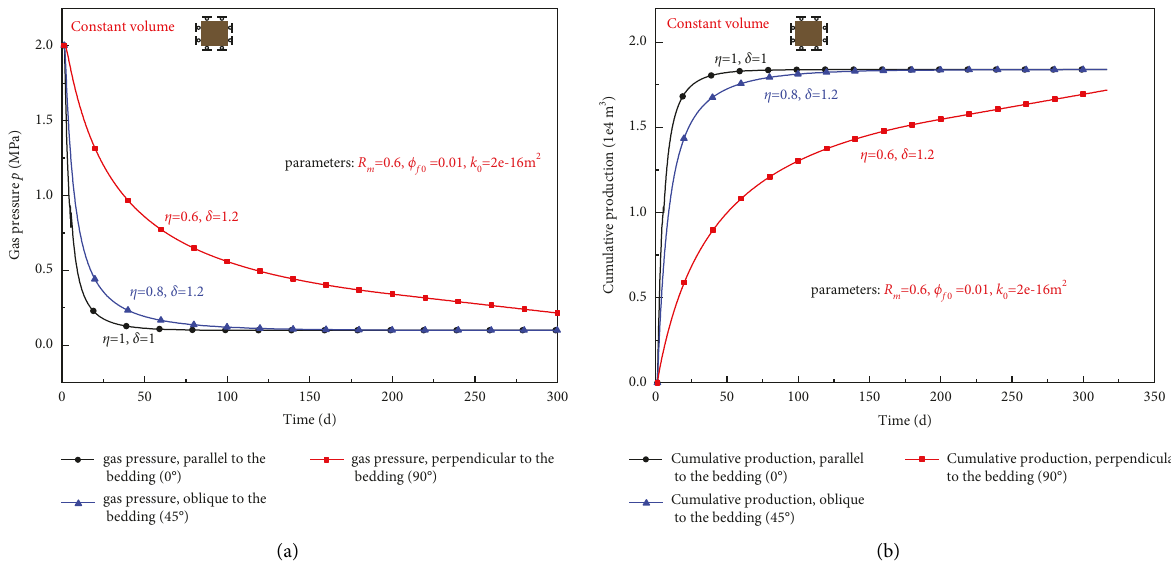
Figure 15: (a) Gas pressure and (b) cumulative production as a function of time under constant volume